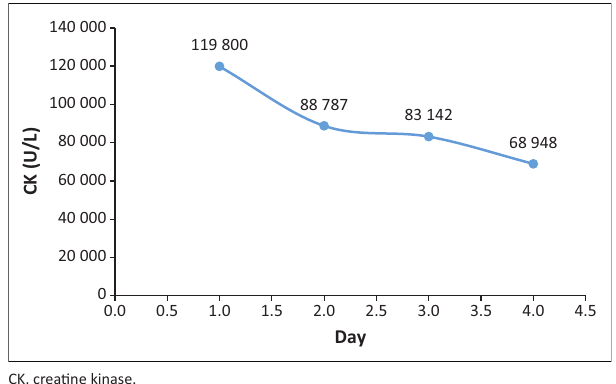
FIGURE 2: Trend in creatine kinase concentration during intravenous fluid